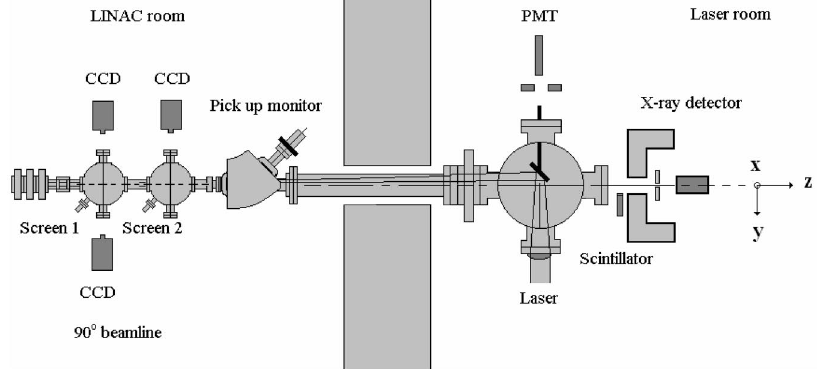
FIG. 6. Top view of experimental setup. The x axis is normal to the figure and the z axis is parallel to the beam line.